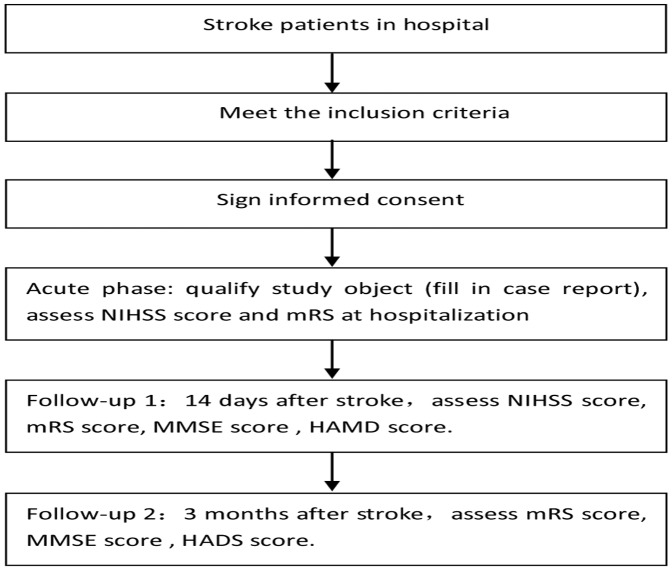
Research Process.